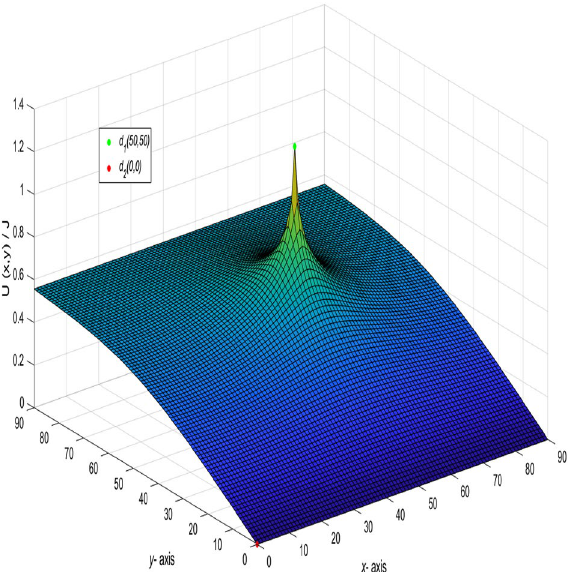
Figure 4. The process of forming a 3D dynamic view for U 90